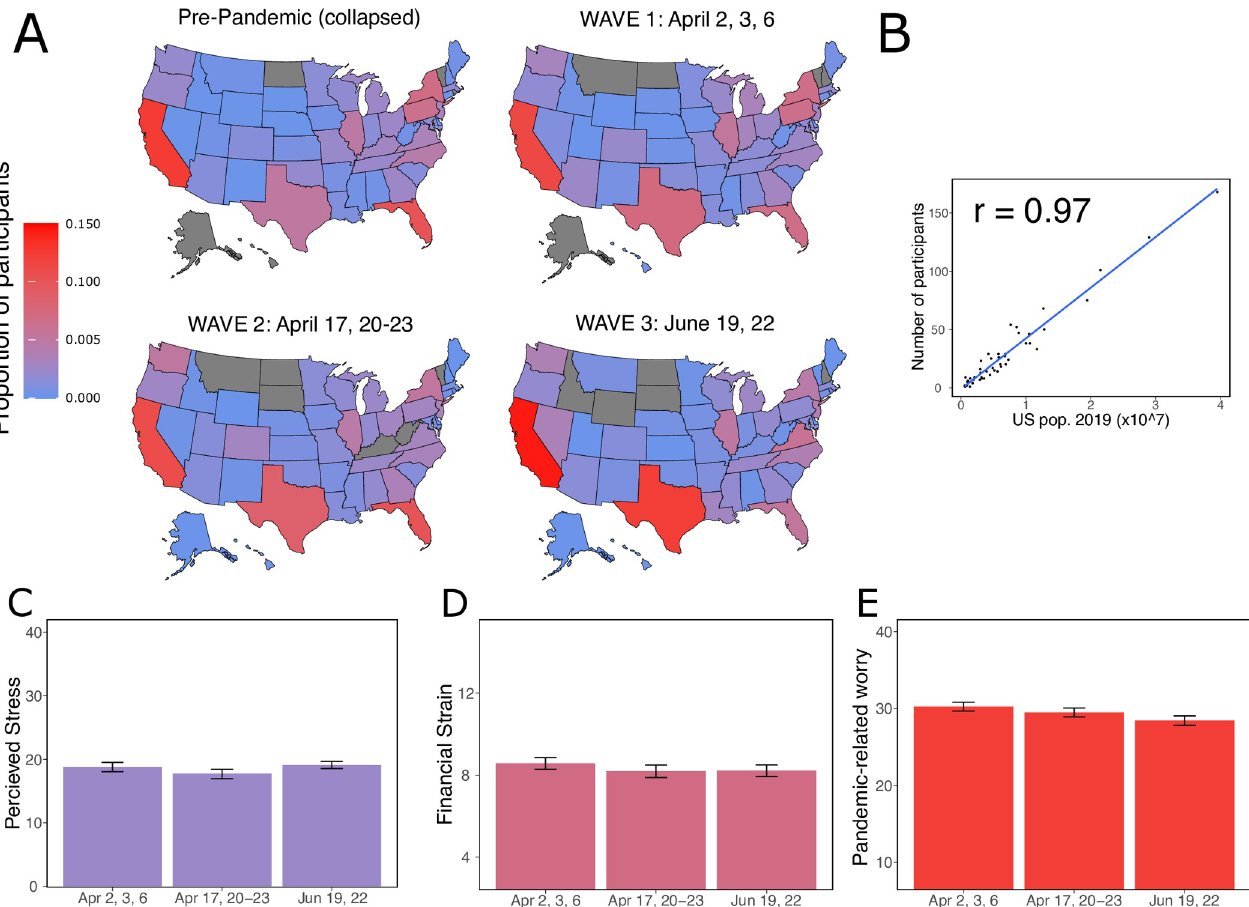
Fig 1. Summary of participant responses across waves of data collection. A. Map of the U.S. depicting the distribution of participants collected during the three samples. B. Correlation between the number of responses per state and the state population. C. Participants reported moderate levels of overall perceived stress which did not vary as a function of wave ( β = -0.321, CI = -0.841–0.198, p = .255); plotted here with 95% bootstrapped confidence intervals. D. Mean self- reported financial strain also decreased with pandemic progression (wave β = -0.232, CI = -0.457—-0.007, p = .042); again, plotted with 95% bootstrapped confidence intervals. E. Mean self-reported coronavirus fear/worry (FCQ) decreased as a function of wave ( β = -1.188, CI = -1.64—-0.733, p < .001); again plotted with 95% bootstrapped confidence intervals.